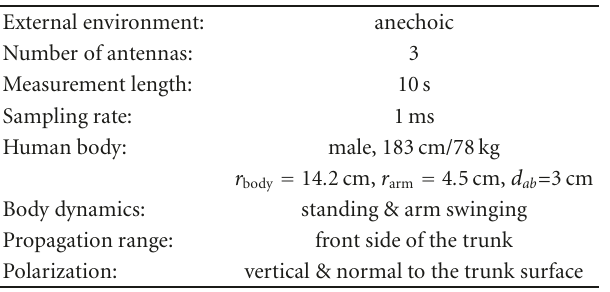
Table 1: Measurement setup.